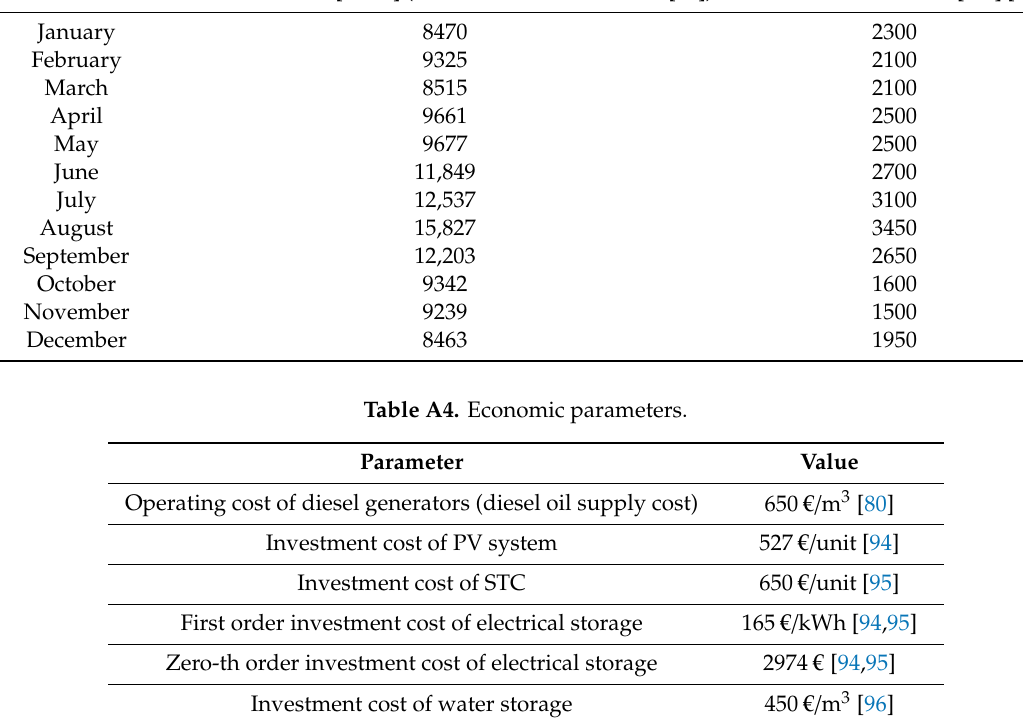
Table A3. Domestic hot water DHW and freshwater demands in monthly standard days in Pantelleria. Month